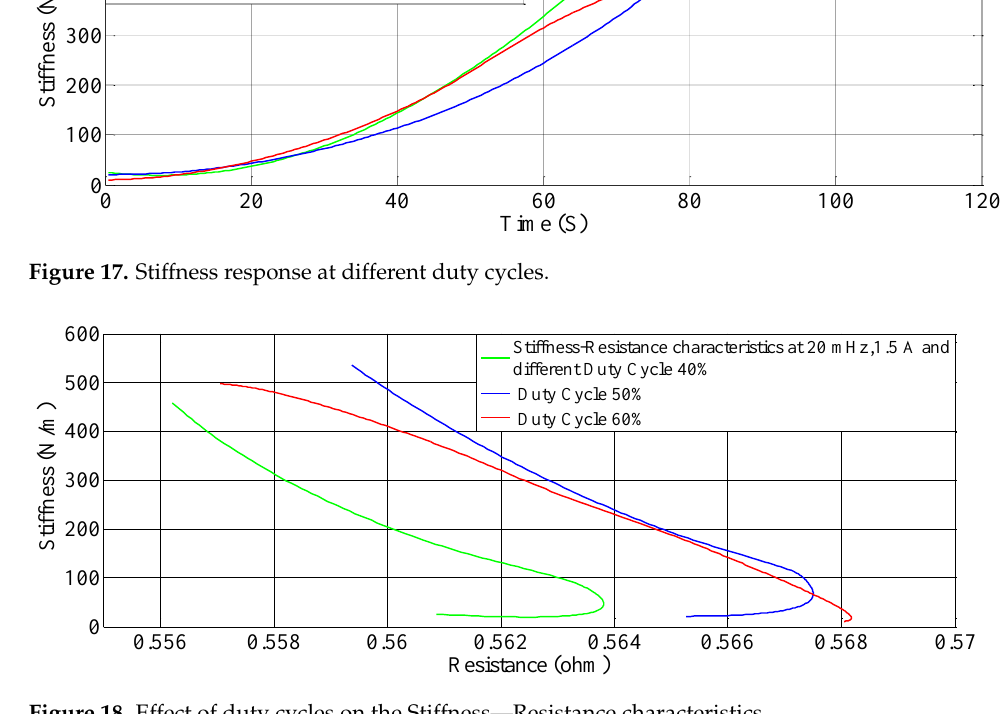
Figure 18. Effect of duty cycles on the Stiffness — Resistance characteristics. Table 15. Resistance and Stiffness at different Duty Cycles. Table 14. Resistance and Stiffness Values at different Pre − Stresses.